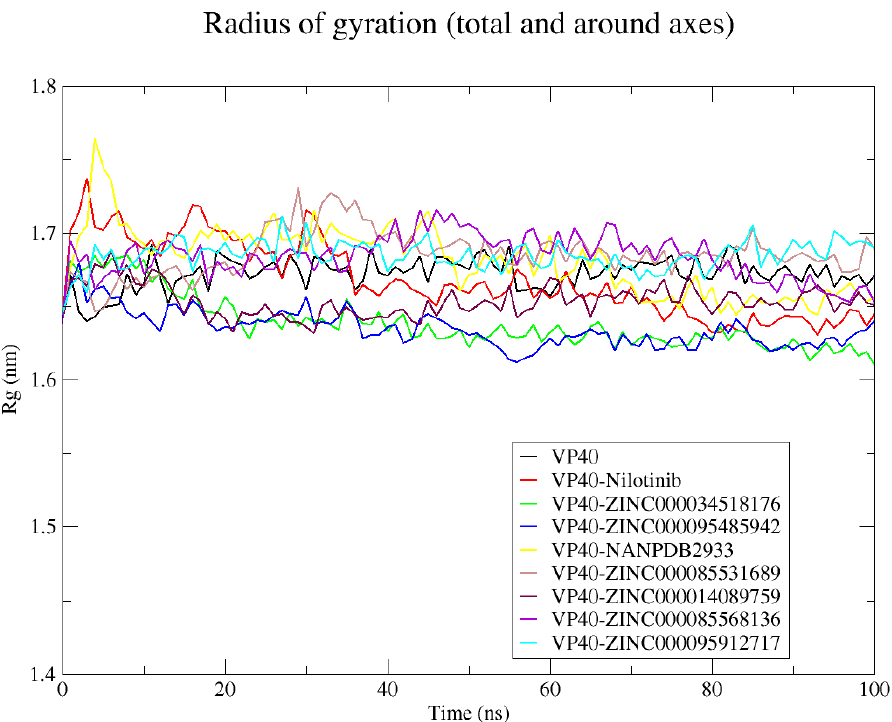
Figure 5. Rg plot of the EBOV VP40 and VP40–ligand complexes after 100 ns MD simulations. The unbound VP40 protein, VP40–nilotinib, VP40–ZINC000034518176, VP40–ZINC000095485942, VP40– NANPDB2933, VP40–ZINC000085531689, VP40–ZINC000014089759, VP40–ZINC000085568136, and VP40–ZINC000095912717 complexes are colored black, red, green, blue, yellow, brown, maroon, violet, and cyan, respectively.